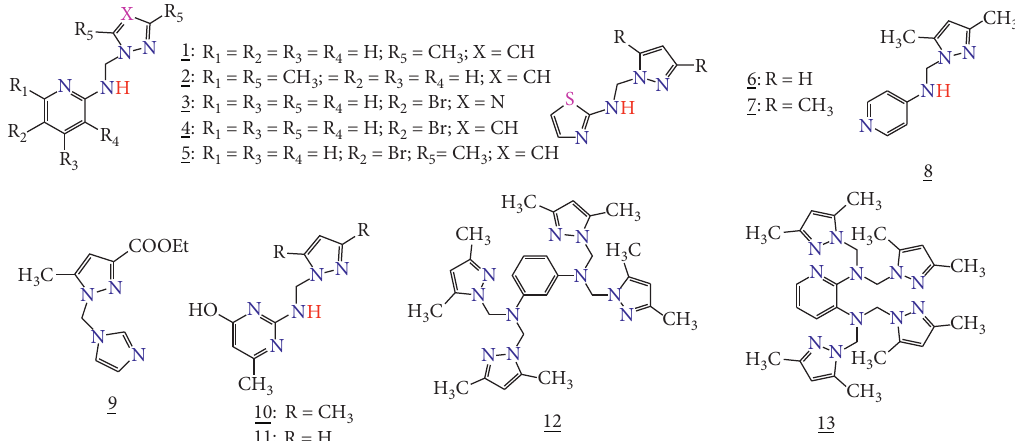
Figure 1: Chemical structure of compounds 1 – 13 studied in this Synthesis of N-((3,5-dimethyl-1H-pyrazol-1-yl)methyl)